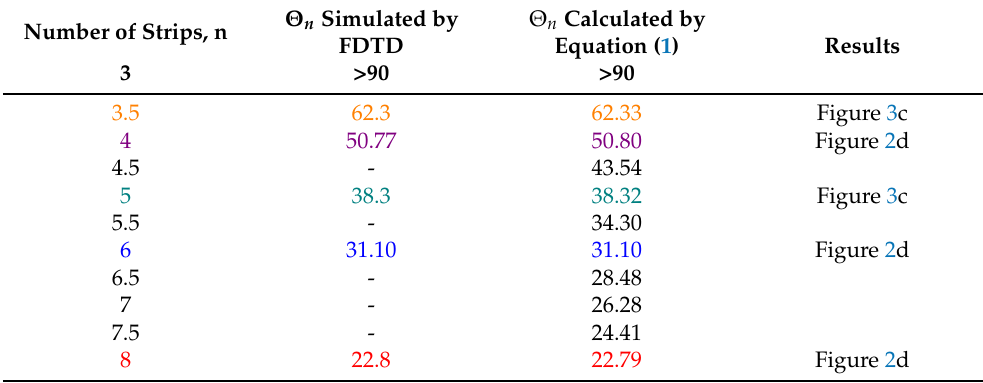
Table 1. The dependence of the ± first order diffraction angle on number of nanostrips. Half-integer n corresponds to double